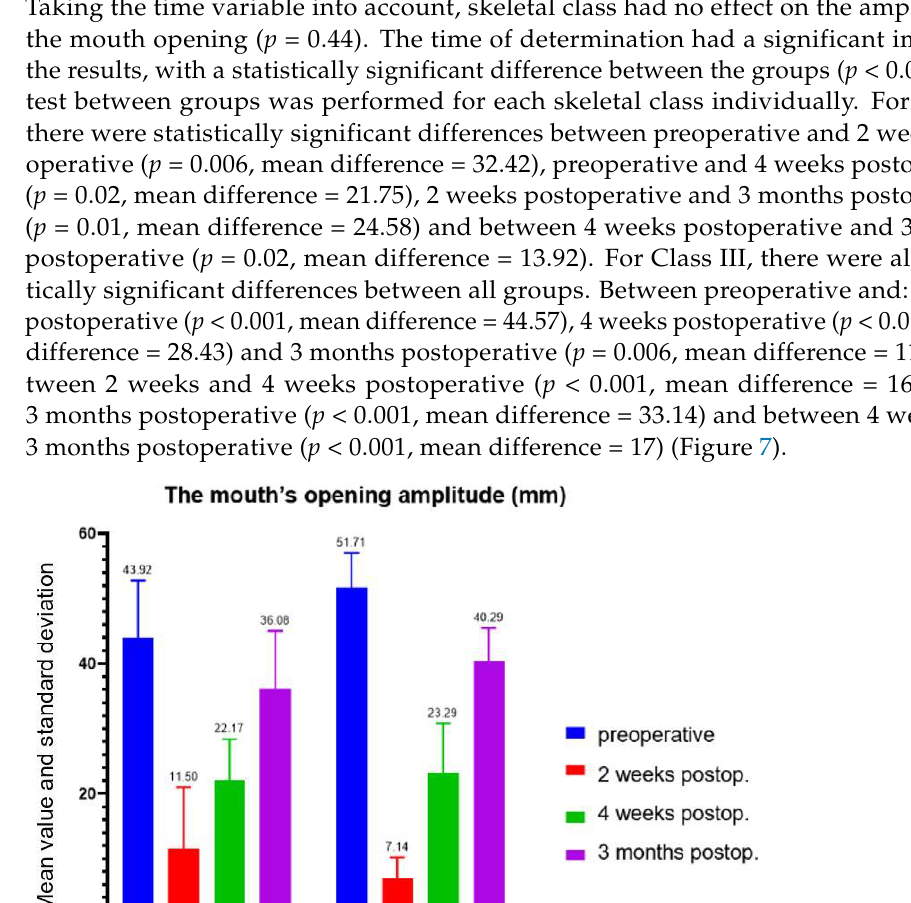
Figure 8. Nose width assessment. The time of determination ( p = 0.91) and skeletal class ( p = 0.11) had no statistically significant influence on the values for the distance between the insertions of the nasal fins. As a result, the group tests were no longer used (Figure 9). In the case of the width of the nose, for the left nostril, the moment of determination ( p = 0.58) and the skeletal class ( p = 0.98) and for the right nostril, class ( p = 0.49) and time of determination ( p = 0.48) did not have a statistically significant influence on the values (Figure 10). Therefore, the group tests were not used. The information gathered for pain evaluation revealed the following data about the affected area: at 48 h, the following areas were the most affected, in descending order: pain in the temporomandibular joint — 1 patient, toothache — 1 patient, and pain of the mandibular angle — 1 patient. One month after surgery, seven patients reported no pain,